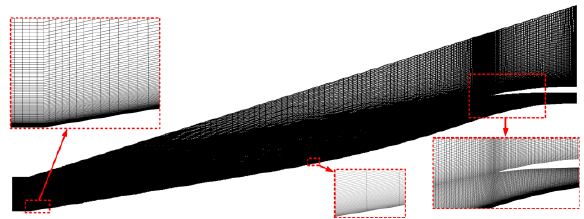
Figure 4. Inlet computational domain and grid.